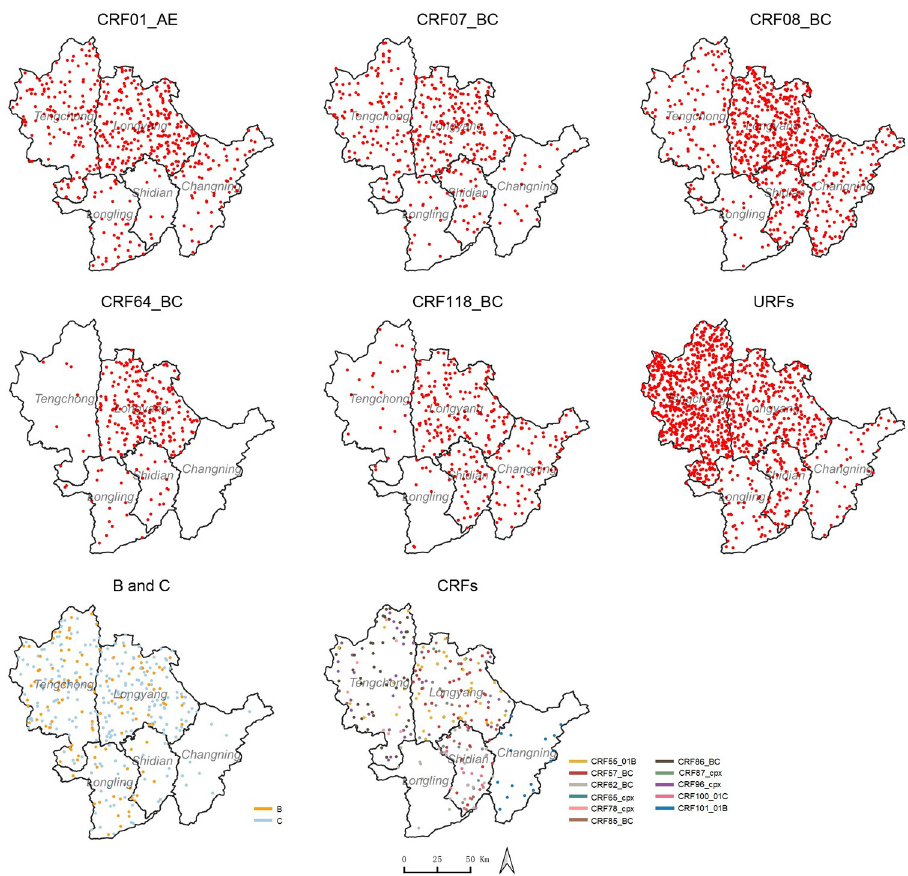
Fig 1. Spatial distribution of HIV-1 genotypes in Baoshan Prefecture. Dot density maps for CRF01_AE, CRF07_BC, CRF08_BC, CRF64_BC, CRF118_BC, URFs, Subtypes B and C, and CRFs. One dot represents 0.025% of the total cases genotyped. The shapefile of China was downloaded from the GADM database (www.gadm.org), version 3.4, April 2018, from which the shapefile of Baoshan Prefecture of Yunnan Province was extracted using Quantum